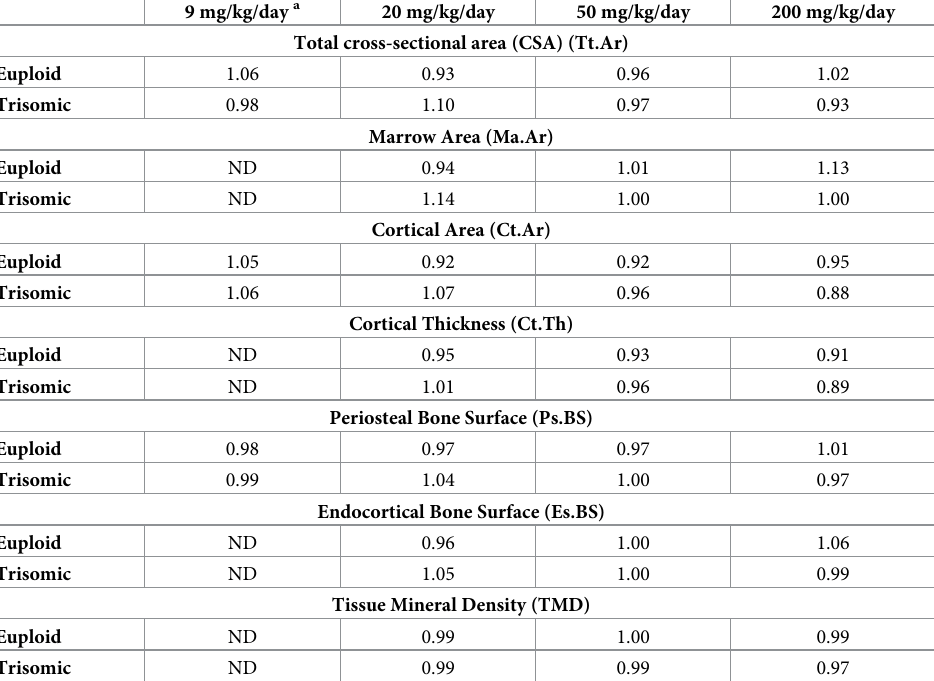
and neurobehavioral measurements in DS mouse models [43–47]. For bone, in mouse models of DS given GTE with different concentrations of EGCG, there was limited improvement in BV/TV, and some other trabecular parameters, but overall bone strength was decreased [33]. When ~9 mg/kg/day pure EGCG was administered from 3–6 weeks of age in male mice, there were improvements in trabecular bone and increased bone toughness, but other mechanical and material properties were not enhanced. Trabecular parameters were not improved in Ts65Dn male mice given ~20 mg/mg/day. Increasing the dosage of EGCG to 20 mg/kg/day and length of treatment to 7 weeks showed an interactive effect with some improvements in total CSA and Ps.BS in trisomic mice). When multiple treatments of increasing dosages of EGCG were examined together, the overall cortical thickness in trisomic and euploid male mice was reduced as EGCG dosage increased. Higher doses of EGCG treatment resulted in a differential effect on trisomic and euploid mice, with trisomic cortical parameters generally reduced and euploid parameters as EGCG treatment increased in male mice. TMD was largely unchanged with increased EGCG dosage. The reduction of cortical bone parameters in triso- mic male mice may lead to reduced bone strength. Based on the results of these multiple analy- ses of the effects of EGCG on bone in the Ts65Dn DS mouse model, these findings suggest that lower doses of EGCG for shorter treatment durations may improve trabecular parameters in long bones including the femur but may not lead to improved overall bone strength. Higher doses of EGCG may negatively affect bones, especially with trisomic material.